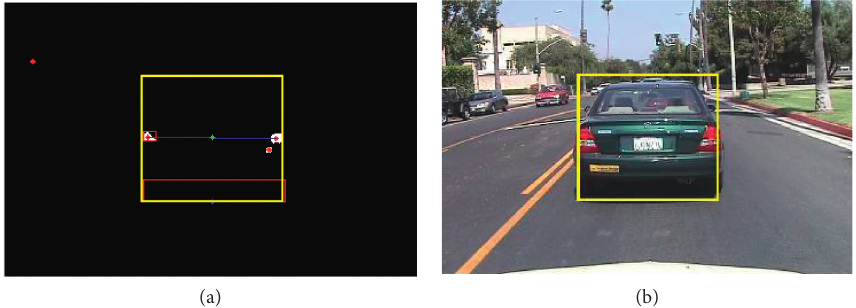
Figure 10: The results of interest region based on the taillight pair and shadow composite feature extraction. (a) Detection results of the interest region based on composite features. (b) Vehicle detection results based on composite